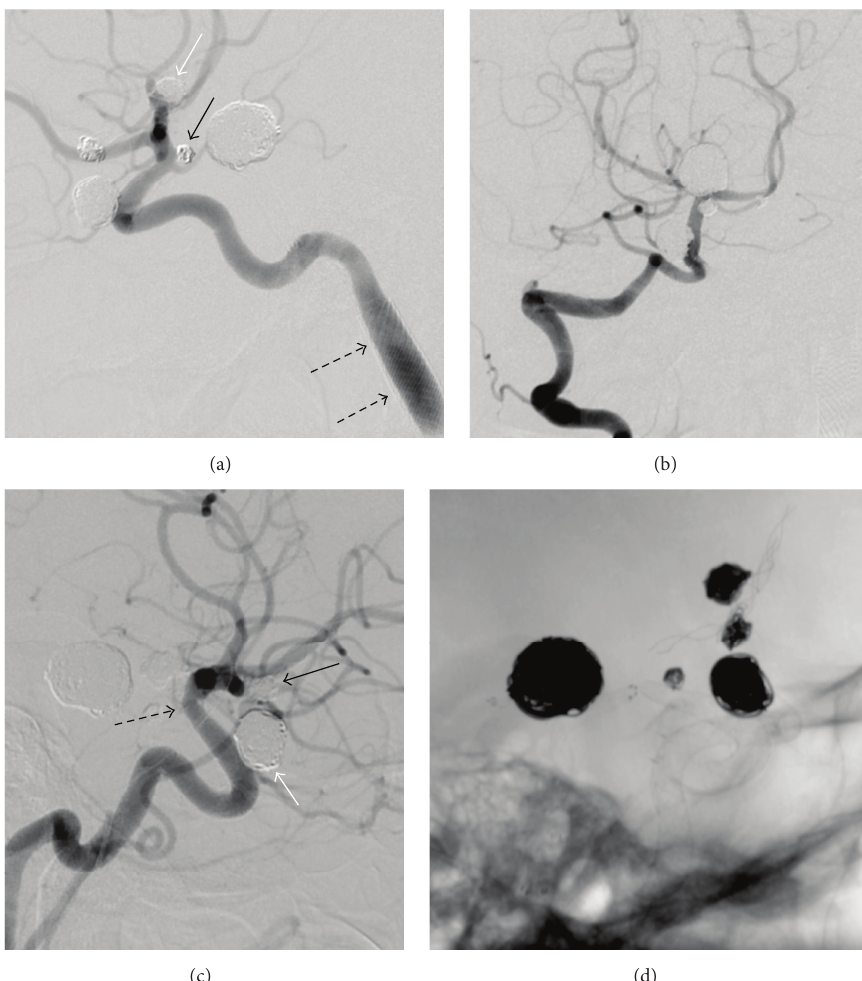
Figure 2: The 9th-month follow-up DSA ((a), (b), and (c)) images show total closure of the aneurysms of the left ICA lacerum segment (a) and the cavernous segment (a), the left anterior choroidal artery (black arrow, (a)), the middle cerebral artery (white arrow, (a)), the basilar tip (b), the anterior communicating artery (black arrow, (c)), and the right ICA ophthalmic segment (white arrow, (c)). The intimal hyperplasia inside the stents seen in the 3rd-month follow-up angiograms (not shown here) was totally relieved. The coils and stents used for the treatment of the aneurysms are seen in the fluoroscopic image (d). A slight fusiform dilation and no in-stent stenosis are seen in the left ICA cervical segment dissection, which was treated with a carotid Wallstent (black dashed arrows, (a)). The 3rd-month DSA (not shown here) showed a slight narrowing, due to the fish mouth or foreshortening effect, inside the distal part of the Surpass stent used for the right ophthalmic segment aneurysms. The 9th-month follow-up DSA (c) showed no change (black dashed arrow, (c)) and no intimal